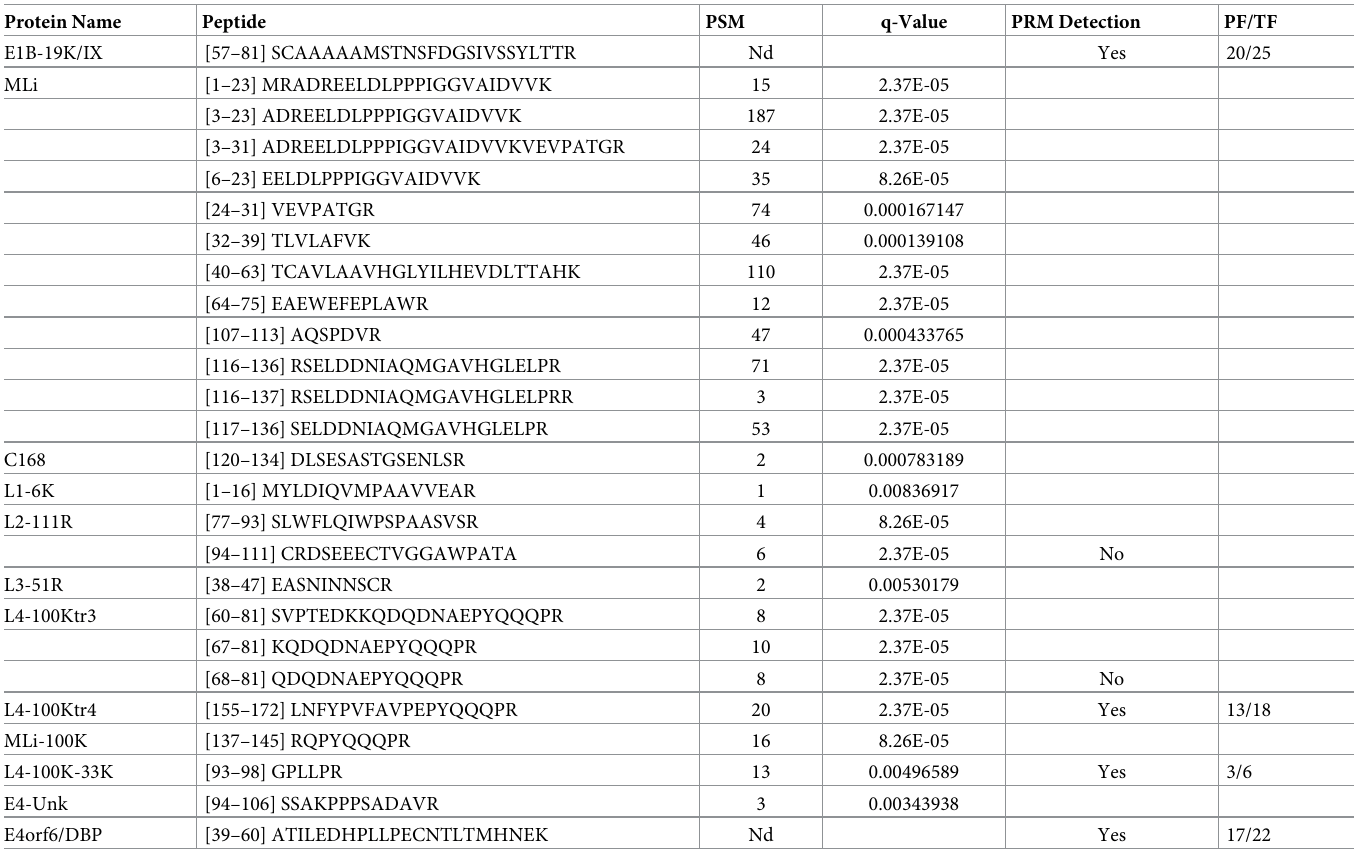
Table 1. Unique peptides of novel AdV ORFs detected by mass spectrometry. Specific detected viral peptides are listed along with their amino acid number in brackets. PSM, peptide spectral match within whole cell proteome. PRM Detection, parallel reaction monitoring run performed. PF/TF, peptide fragments/total possible peptide fragments detected by